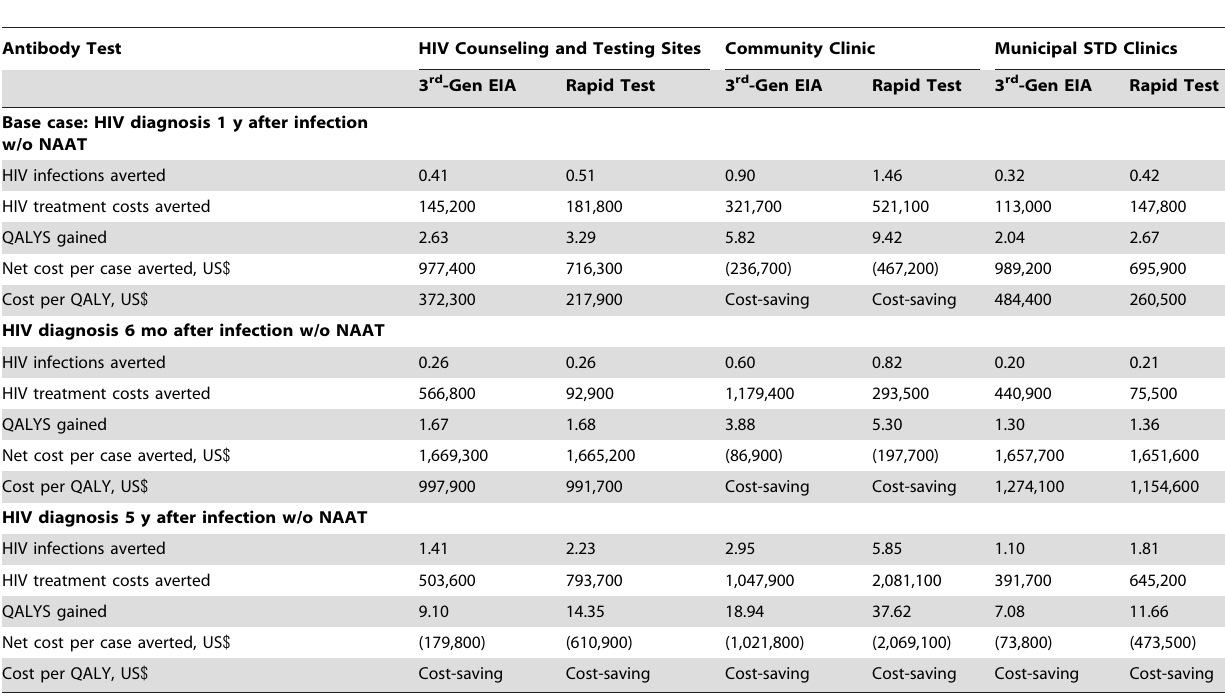
Table 4. Costs-effectiveness of pooled NAAT screening for AHI after third-generation EIA and rapid testing.